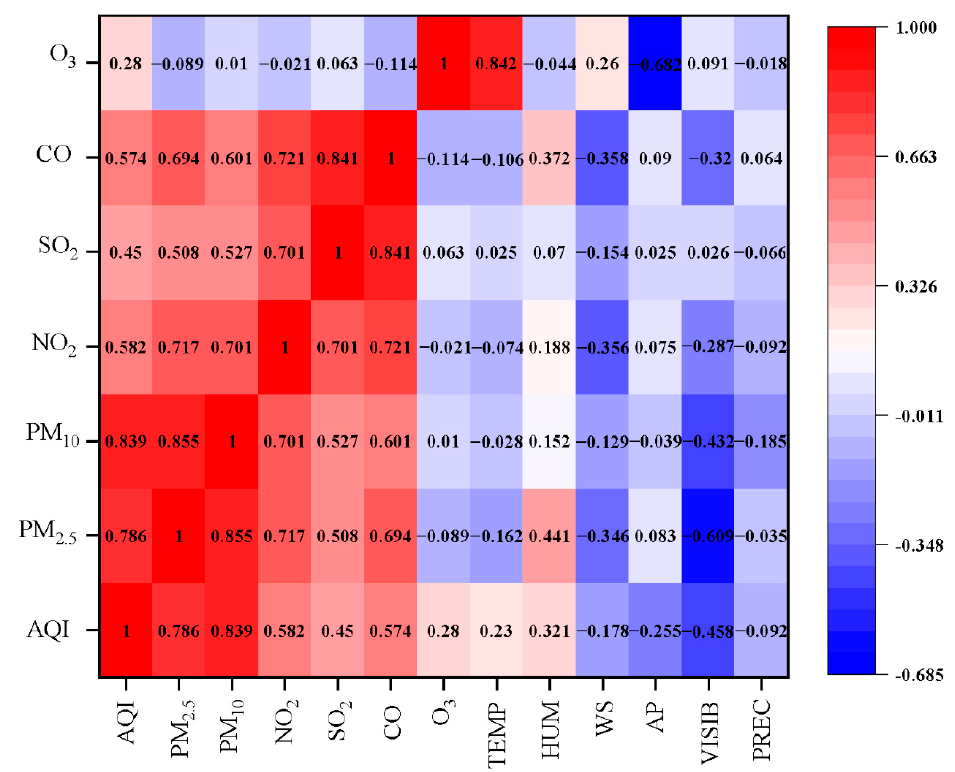
Figure 4. Heat map of the Spearman correlation coefficient for AQI, pollutants, and meteorological parameters. Abbreviations: TEMP, temperature; HUM, humidity; WS, wind speed; AP, atmospheric pressure; VISIB, visibility; PREC, precipitation. Significant correlation was set at p < 0.05.